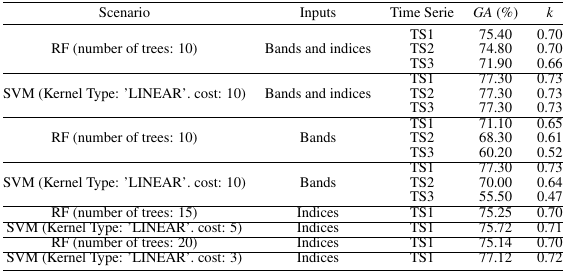
Figure 6. Time series of the median EVI for each sampled class (Scenario 4) 55.5% of GA , nevertheless in only two cases the k value is fair (Table 8).